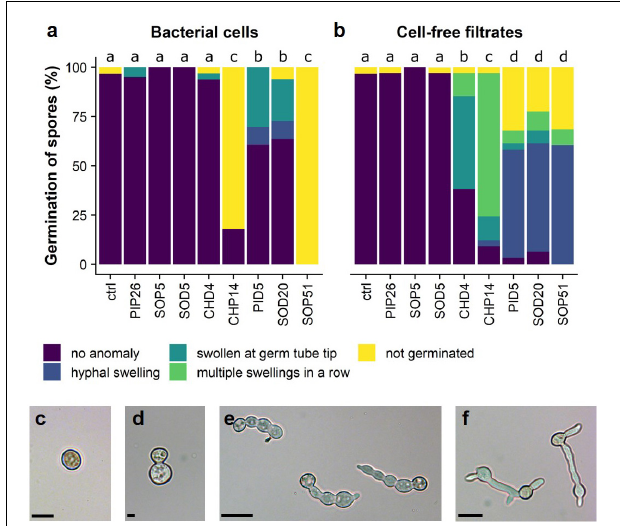
FIGURE 5 | Perturbed development of germinated spores of B. cinerea. Proportions of anomalies observed in bacterial cell-exposed spores are shown in (a) , those observed in cell-free filtrate-exposed spores are shown in (b) . Different letters indicate significantly different proportions of anomalies according to a Chi-square test with Yate’s correction for continuity ( p < 0.05). The different types of anomalies observed in germinating spores of B. cinerea are shown in (c–f) : (c) not germinated; (d) hyphal swelling; (e) multiple swellings in a row; (f) swelling at germ tube tip. Scale bars = 30 µ m. The experiment was repeated twice with similar